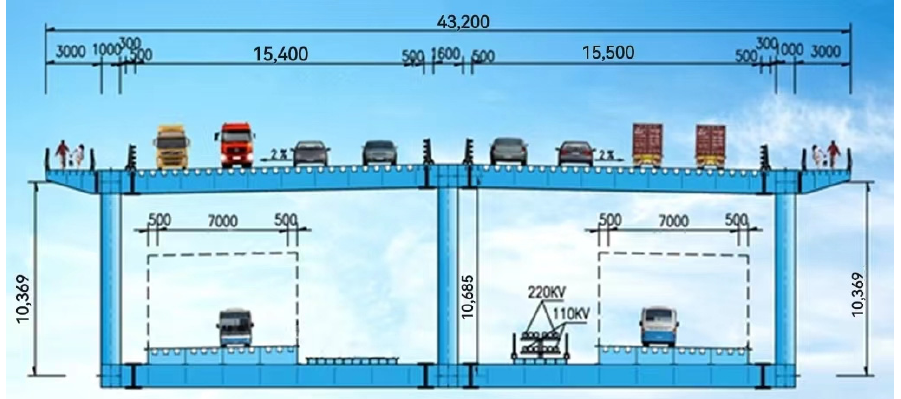
Figure 3. The Layout of the upper and lower decks (mm).